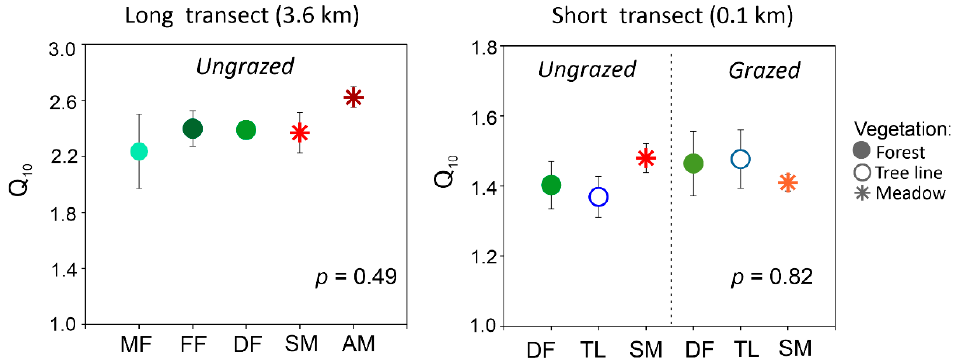
Figure 2. Temperature sensitivity of soil organic matter decomposition (Q 10 ) of mountain forest and meadow sites along long (on the left) and short transects (on the right) with different land use. Note: MF, mixed forest; FF, fir forest; DF, deciduous forest; SM, subalpine meadow; AM, alpine meadow; TL, tree line. Symbols show means with standard error ( n = 3). p ‐ value for results of Kruskal–Wallis ANOVA.